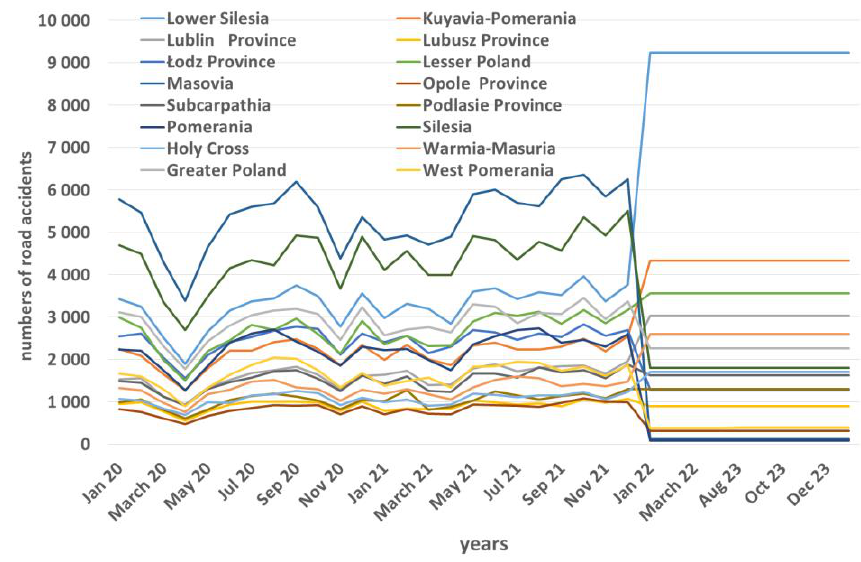
Figure 7. Forecasting monthly number of road accidents for 2022 – 2023. Table 4. Summary of errors for annual data.